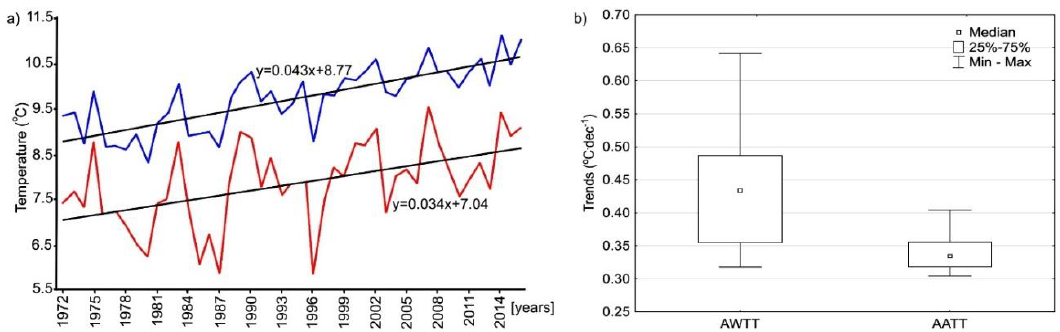
Figure 6. Course of the average annual water temperature (for all lakes—blue colour), and course of the average annual air temperature (for all stations—red colour) ( a ), and significance of differences in trends of average annual water temperatures (AWTT) and monthly and annual air temperatures (AATT) ( b ) in the years 1972–2016. High dependencies between water temperature in the analysed lakes and air temperature evidenced earlier are confirmed by Table 4. Table 4. Correlations between average air temperatures and average water temperatures (relations of lakes and meteorological stations located at the shortest distance).